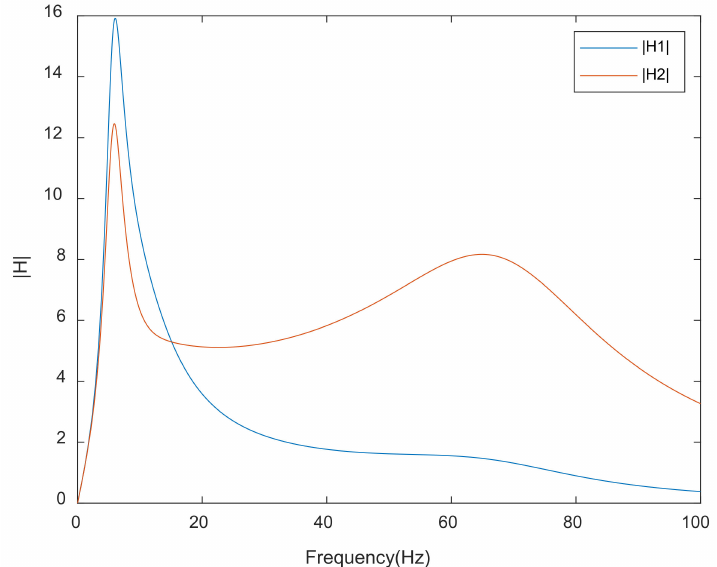
Figure 2. Frequency response characteristic